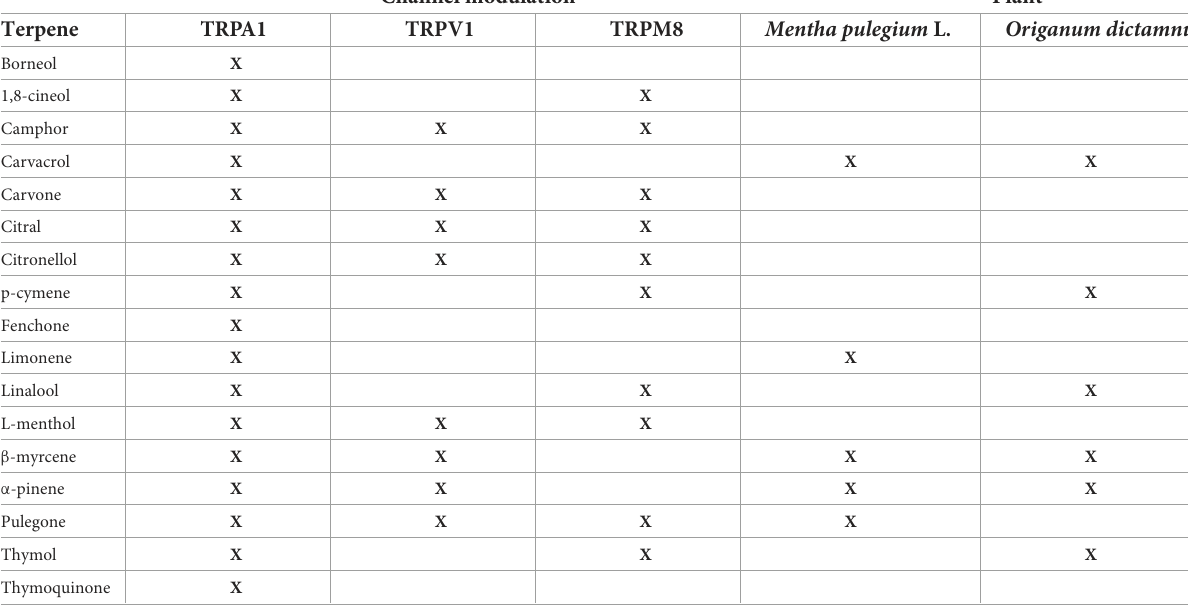
TABLE 1 Anti-inflammatory monoterpenes modulating TRP channel activity compared to the essential oil of Mentha pulegium L. and Origanum dictamnus L. Channel modulation Plant TRPV1 TRPM8 Mentha pulegium L. Origanum